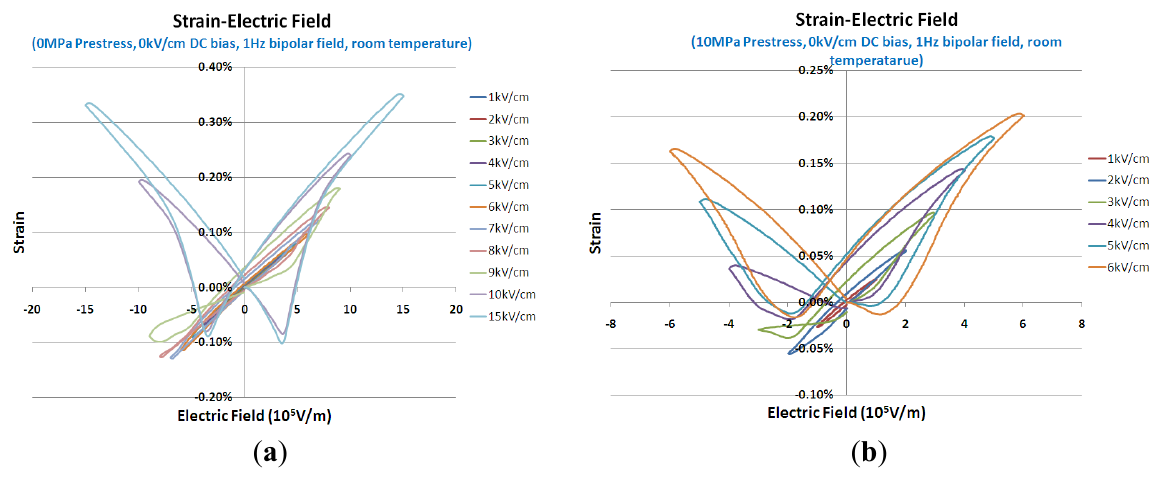
Figure 9. S-E loops measured under a bipolar electric field and 0 MPa ( a ) and 10 MPa ( b ) uniaxial prestress (Mn:PIN-PMN-PT crystal in rhombohedral phase). Reprinted with permission from [86]. Copyright 2013 IEEE.